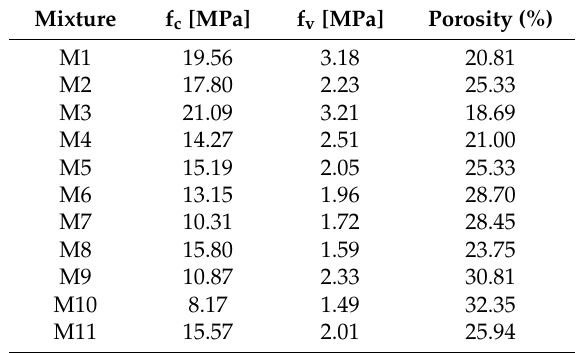
Table 3. Results of pervious concrete compressive strength (f c ), flexural strength (f v ) and porosity.